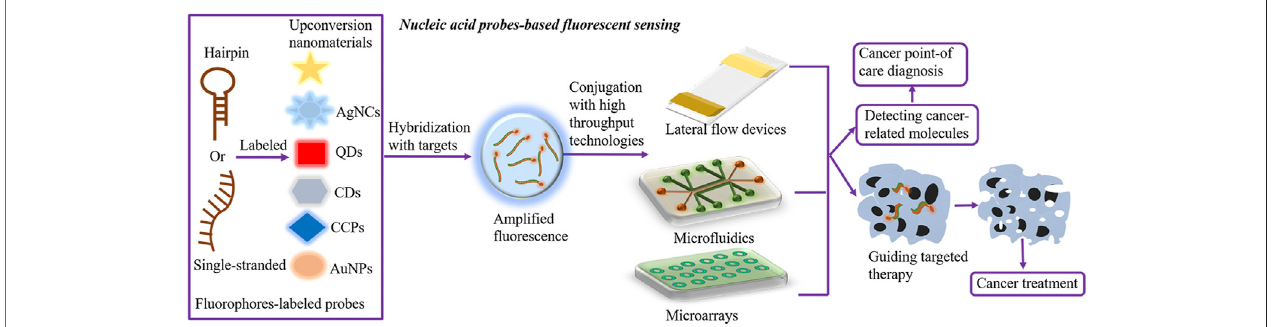
FIGURE 1 | Nucleic acid probe – based fl uorescent sensing. Hairpin or single-stranded nucleic acid probes are labeled with fl uorophores to construct nucleic acid probe – based fl uorescent sensing platforms. Effective fl uorophores comprise QDs, CDs, AgNCs, AuNPs, CCPs, and upconversion nanomaterials. In the presence of